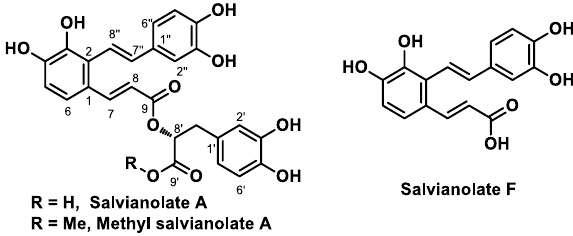
Figure 1. The structures of salvianolate F and A, and (±)-methyl salvianolate A.